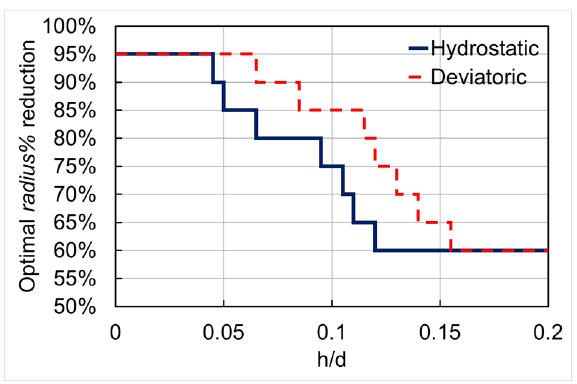
Figure 3. Optimal radius% (corresponding to area% for DIC) as a function of relative milling depth h / D (dashed line: deviatoric part, full line: hydrostatic part).